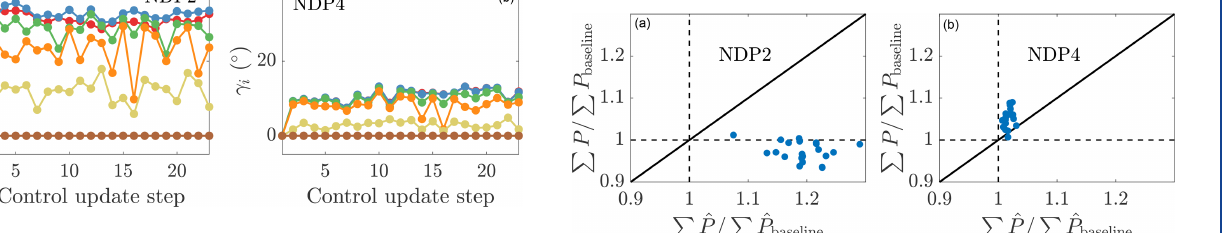
Figure 18. Yaw misalignment angles for each turbine in the wind farm for online control using the initial parameters to initialize the next state and (a) ˆ P p = 2 (NDP2) and (b) ˆ P p = 4 (NDP4). trol update 2 and can be compared directly to ˆ P yaw to vali-